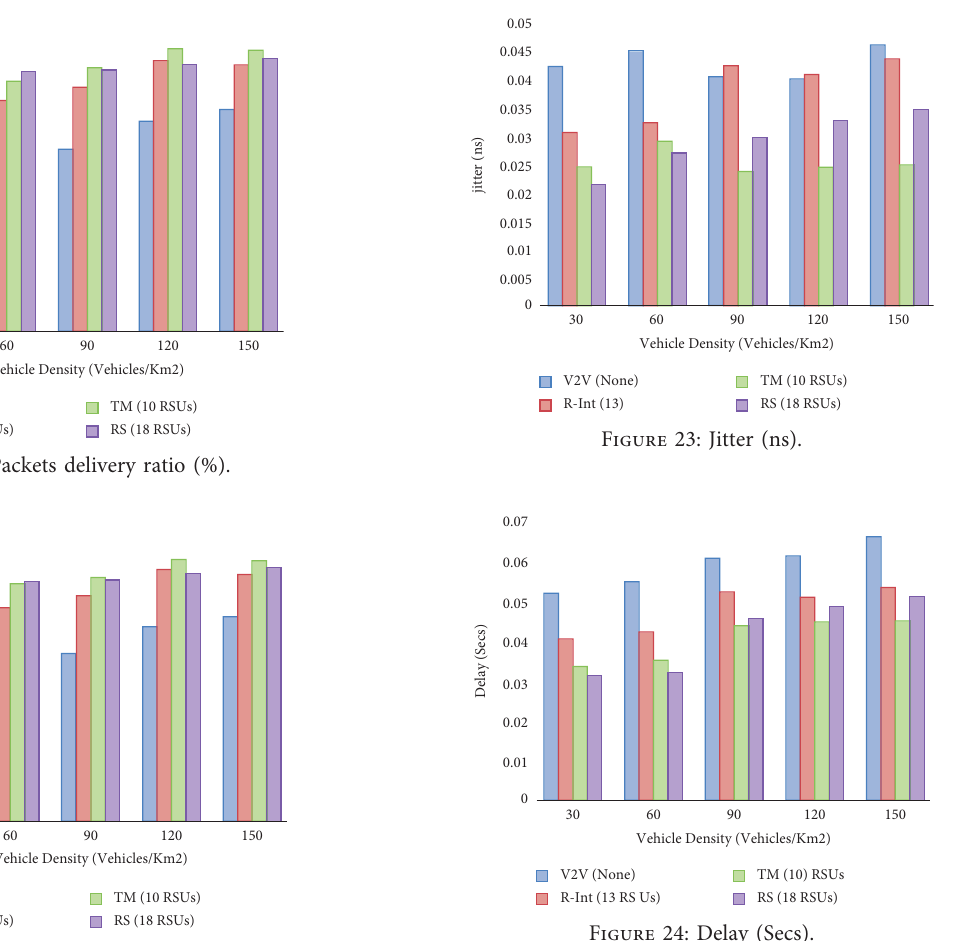
Figure 22: Throughput (kbps).